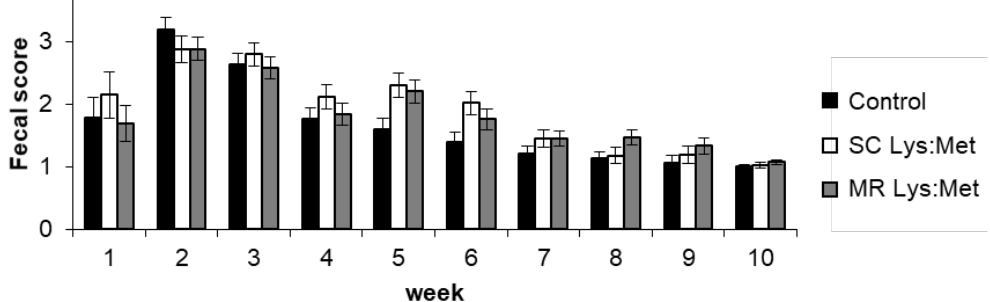
Figure 4. Fecal score of dairy calves with or without lysine and methionine supplementation in starter concentrate or milk replacer. Error bars indicate standard error of the mean.